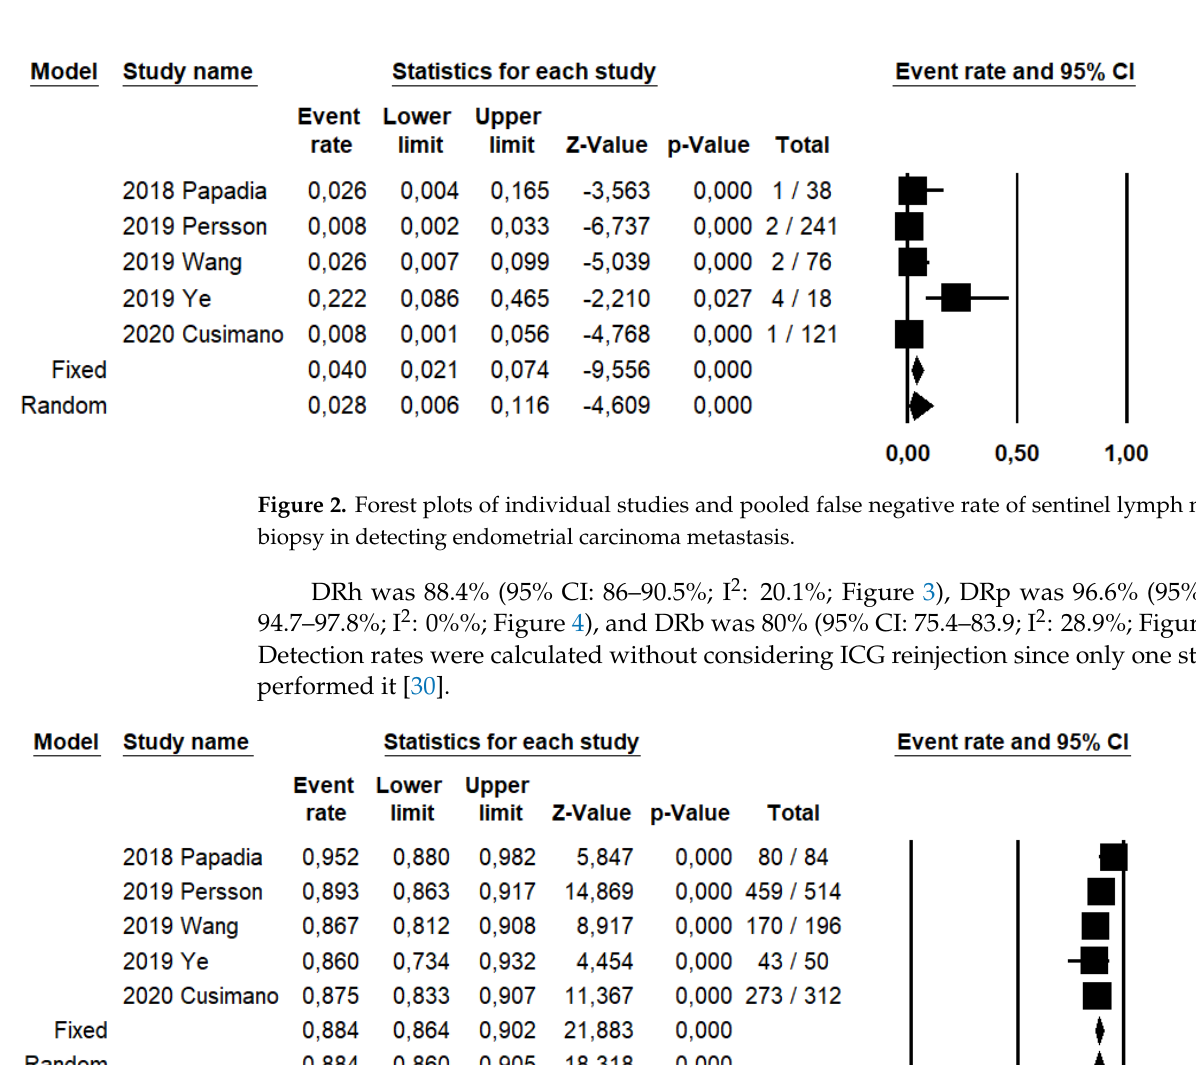
Figure 1. Forest plots of individual studies and pooled sensitivity of sentinel lymph node biopsy in detecting endometrial carcinoma metastasis.